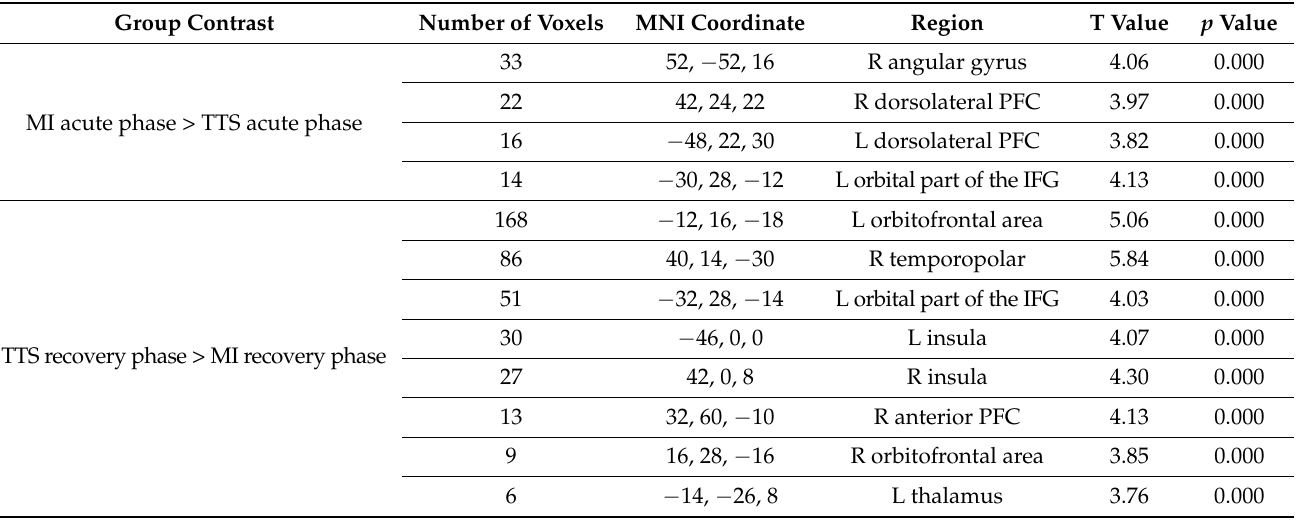
Table 4. Significant group differences between TTS and MI while viewing the aversive versus positive pictures during the emotional task-based fMRI